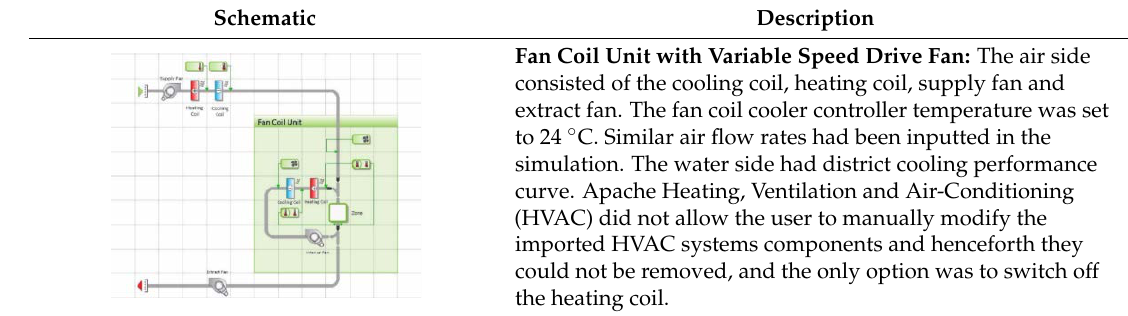
Table 7. Cooling systems modelled.